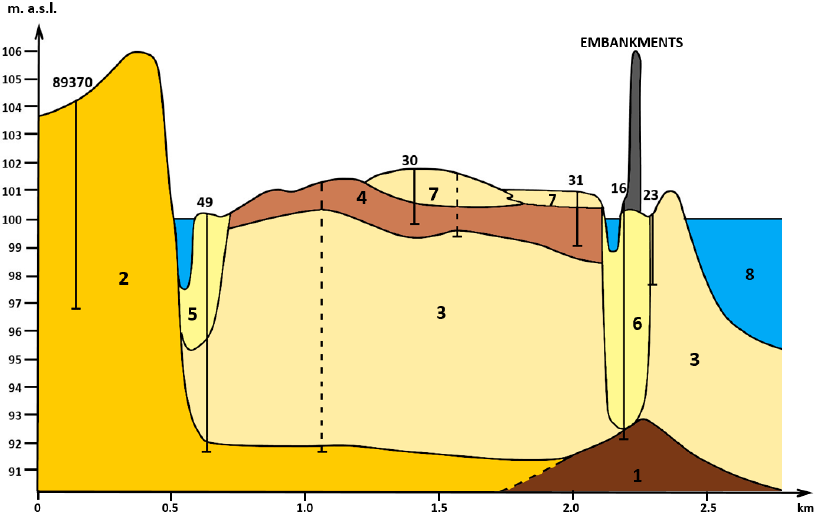
Figure 4. Schematic geological cross-section. 1—sub-alluvia bedrock protrusion (loam); 2—Pleisto- cene upper terrace (sand); 3—Holocene alluvia (sand and gravel); 4—Holocene alluvia (loams and clays); 5—oxbow lake partially filled with flood deposits (sand); 6—crevasse channel (sand); 7— contemporary alluvia; 8—Vistula channel.